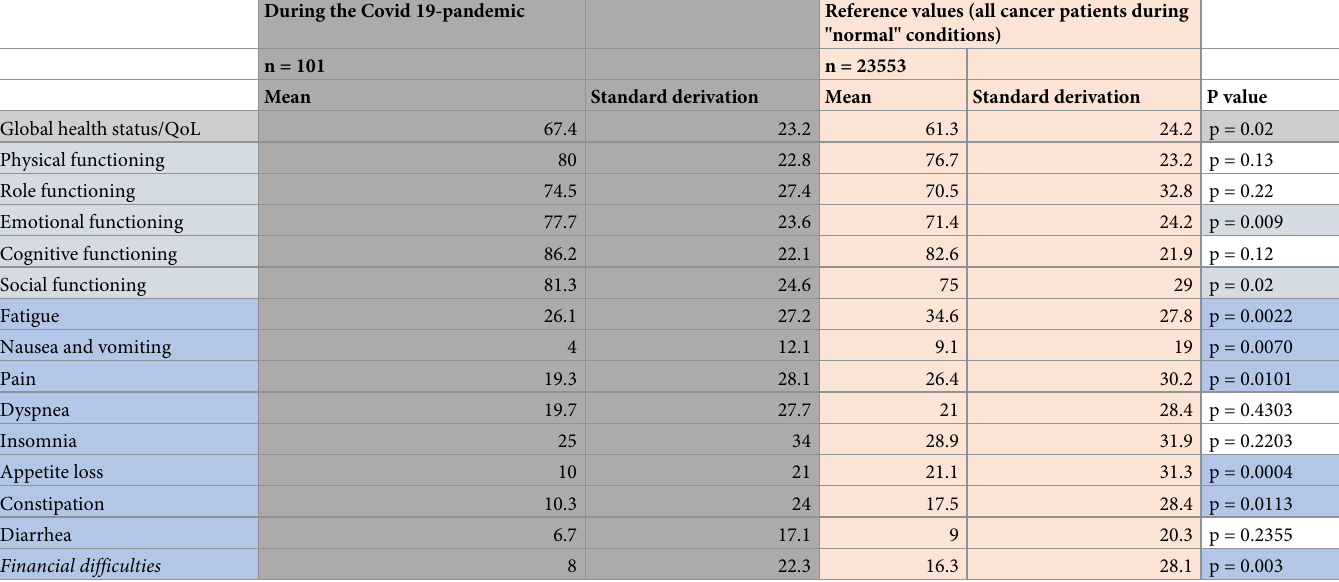
Table 3. EORTC quality of life questionnaire—C30 in comparison to reference values "all cancers/all stages". During the Covid 19-pandemic Reference values (all cancer patients during "normal"